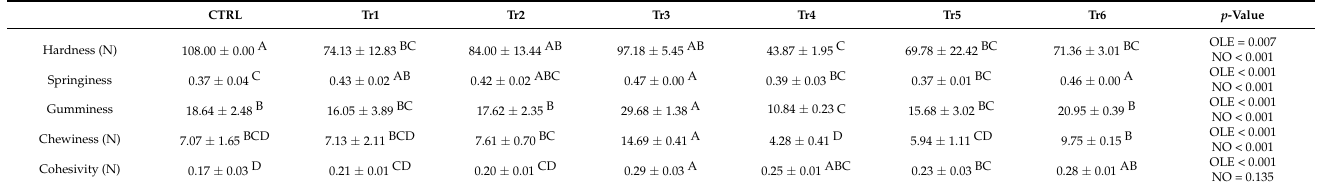
Table 6. Mean value, standard deviation, and results of the statistical analysis (two-way ANOVA) of the textural parameters of the ripened sausages under investigation ( n =